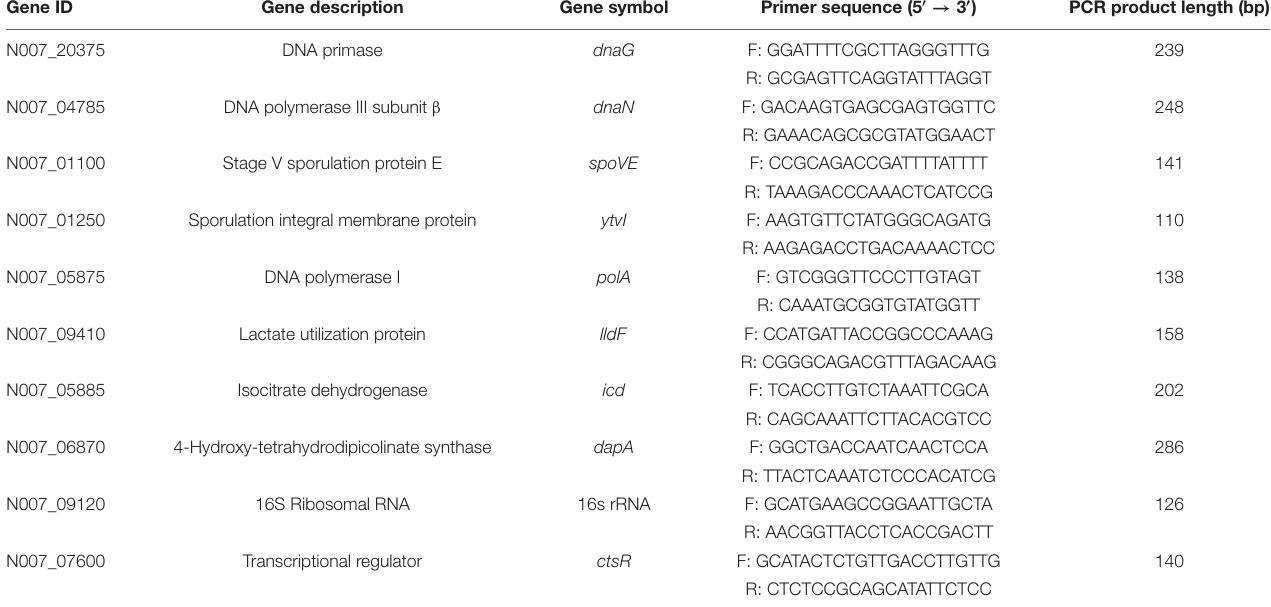
TABLE 1 | Gene descriptions and primer sequences used for